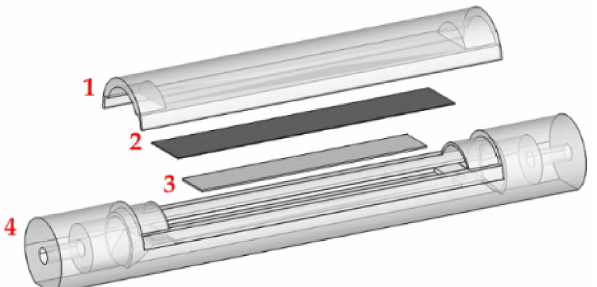
Figure 1. Schematics of the sensor cell, which includes cover (1), magnetoelastic microribbon (2), permanent magnet (3), and main body (4).